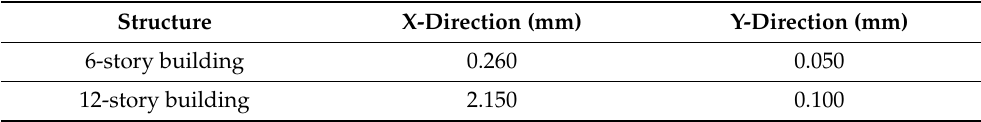
Table 4. Maximum displacement comparison from the static linear analysis.